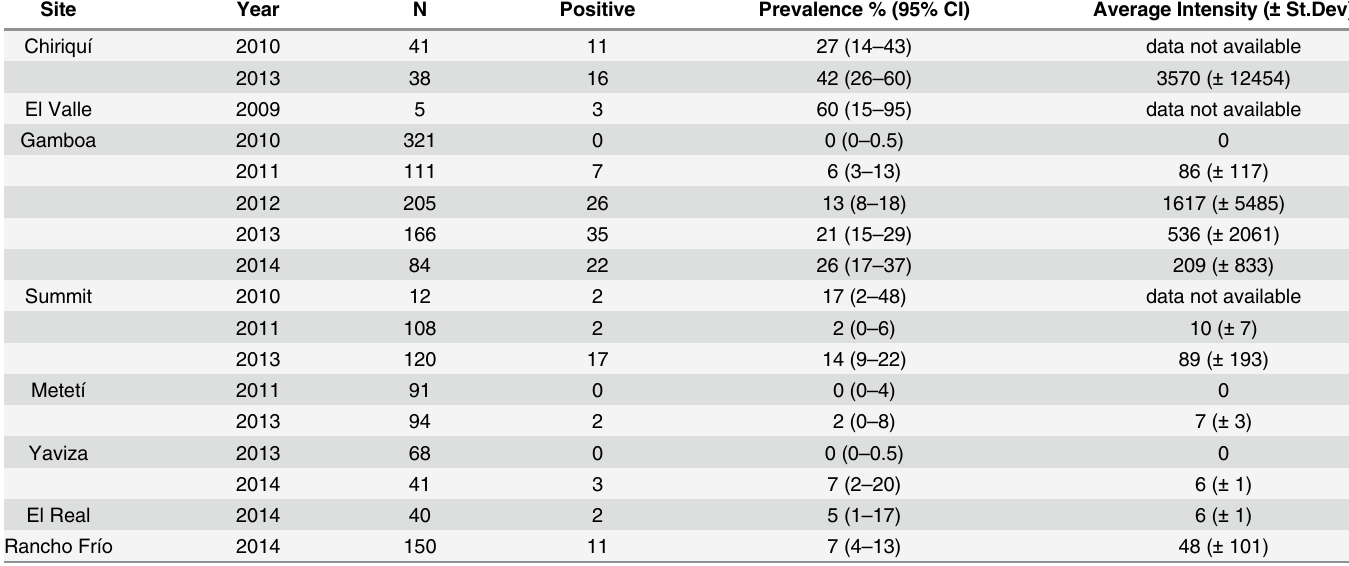
Table 1. Bd prevalence and infection intensity per site and year in Túngara frog ( Physalaemus [Engystomops] pustulosus ) populations sampled in this study (n = number of individuals sampled; Positive = number of individuals detected positive for Bd ; 95% CI = 95% binomial distribution confi- dence intervals; Average intensity = average of number of zoospore equivalents in infected frogs per population). Sites are arranged west to east by